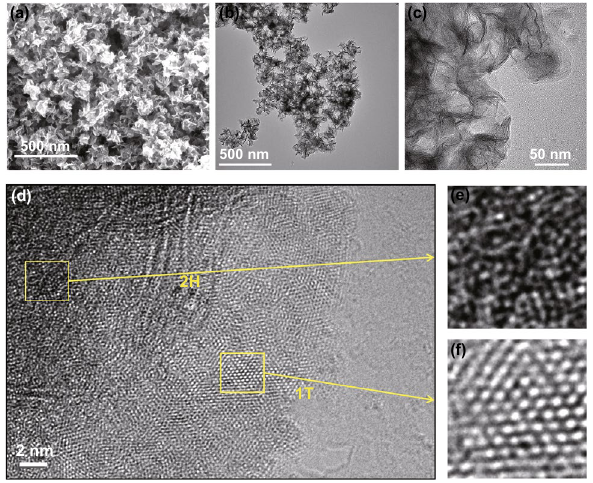
Fig. 2 a SEM image, b , c TEM image, d HRTEM images of 1T/2H MoS 2 . e , f Enlarged images of the selected yellow area